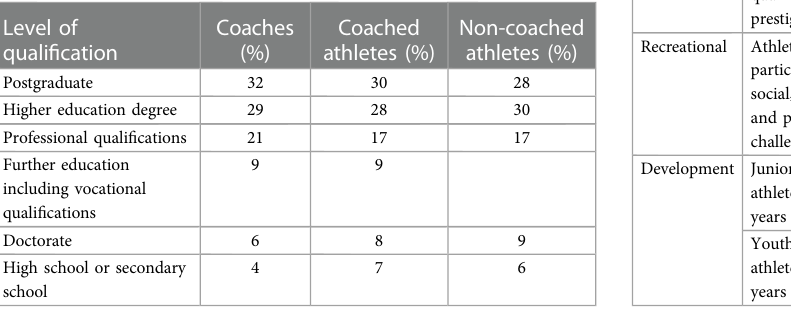
TABLE 1 Highest level of education between groups.